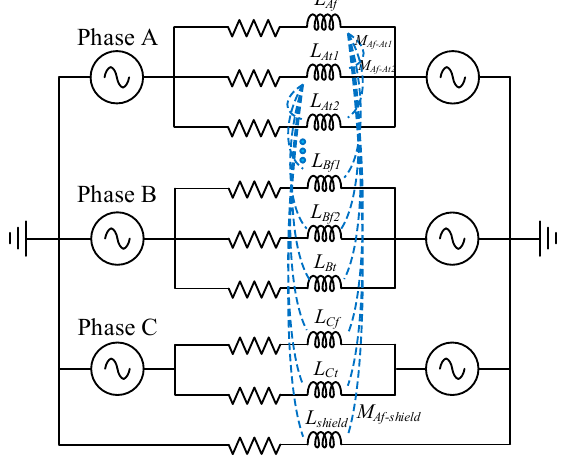
Figure 3. The equivalent circuit of the HTS power cable.